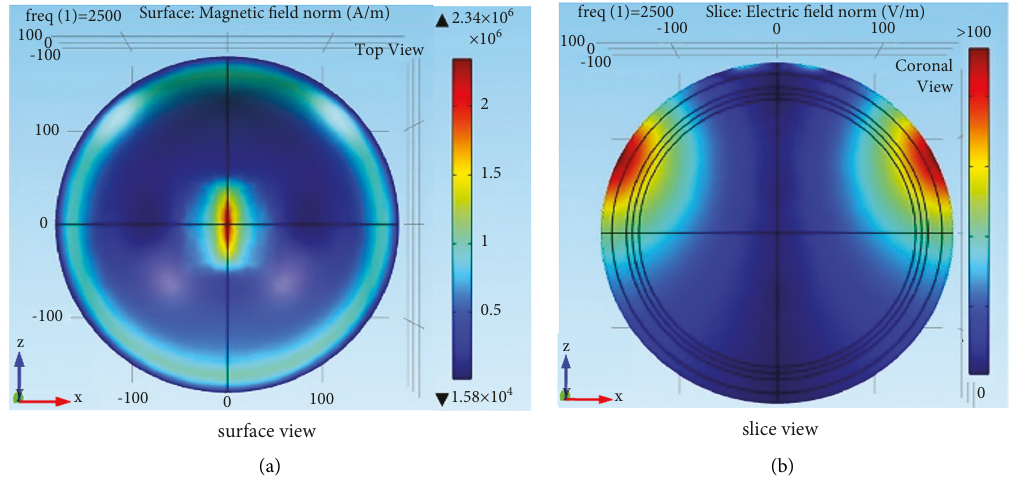
Figure 10: (a) Magnetic field and (b) electric field distribution of the HVA coil with a magnetic shield